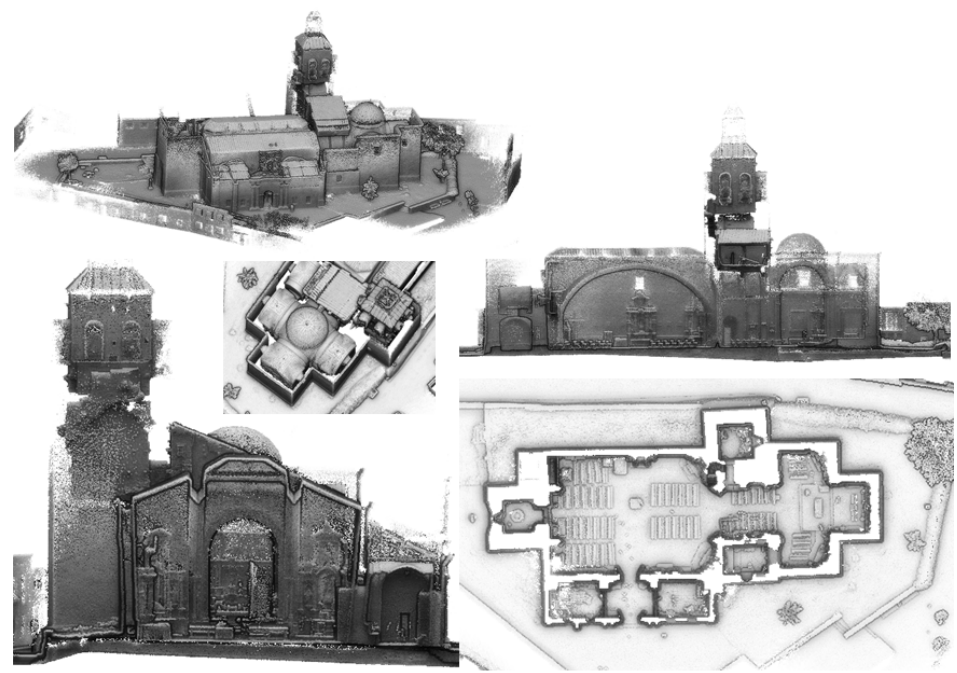
Figure 7. 3D point cloud obtained during the digitalization process with the WMMS.